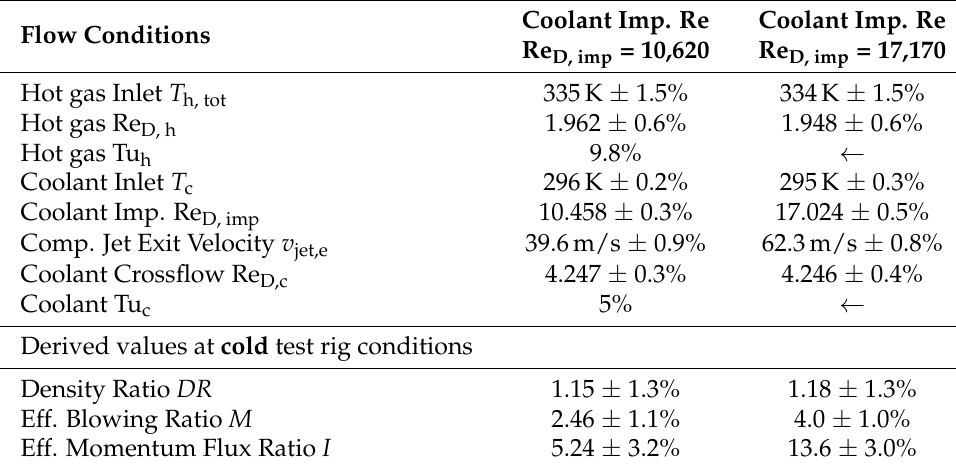
Table 2. Overview of operating conditions. Data are shown for both nominal impingement Reynolds numbers. Deviation of values over all six different test configurations given for each Reynolds